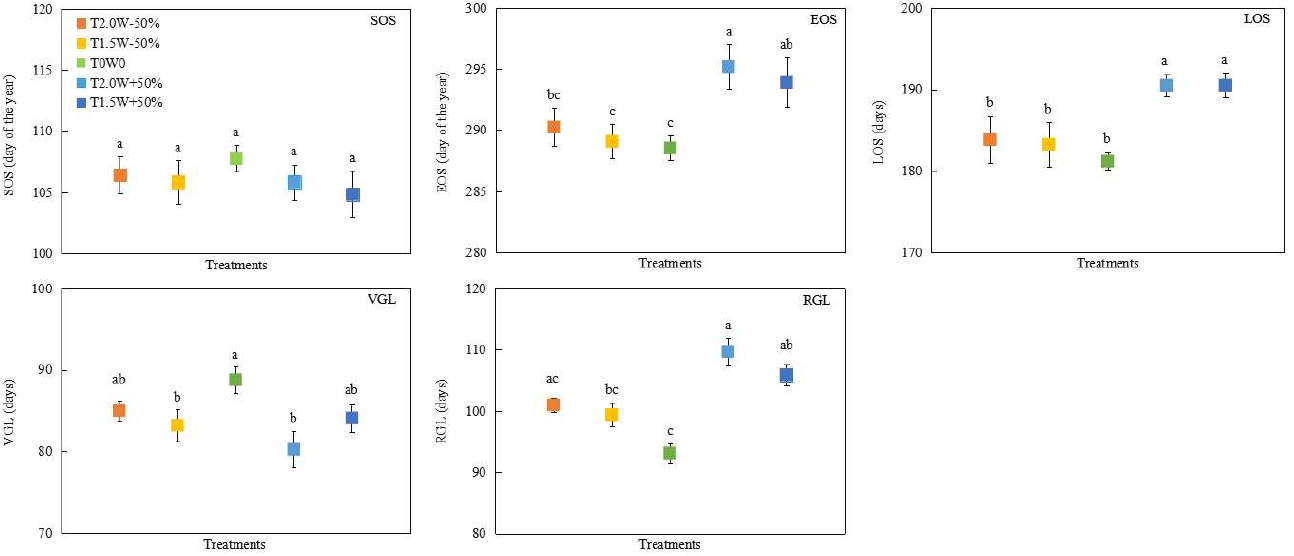
Figure 1. Effects of temperature and precipitation treatments on phenological change of Stipa krylovii (means ± SE). T0W0: ambient temperature and precipitation; T1.5W − 50%: 1.5 °C warming and 50% precipitation reduction; T1.5W + 50%: 1.5 °C warming and 50% precipitation addition; T2.0W − 50%: 2 °C warming and 50% precipitation reduction; T2.0W + 50%: 2 °C warming and 50% precipitation addition. SOS represents the start of the growing season; EOS represents the end of the growing season; LOS represents the length of growing season; VGL represents vegetative growth length; RGL represents reproductive growth length. Different lowercase letters were used to indicate significant differences among treatments ( p < 0.05).